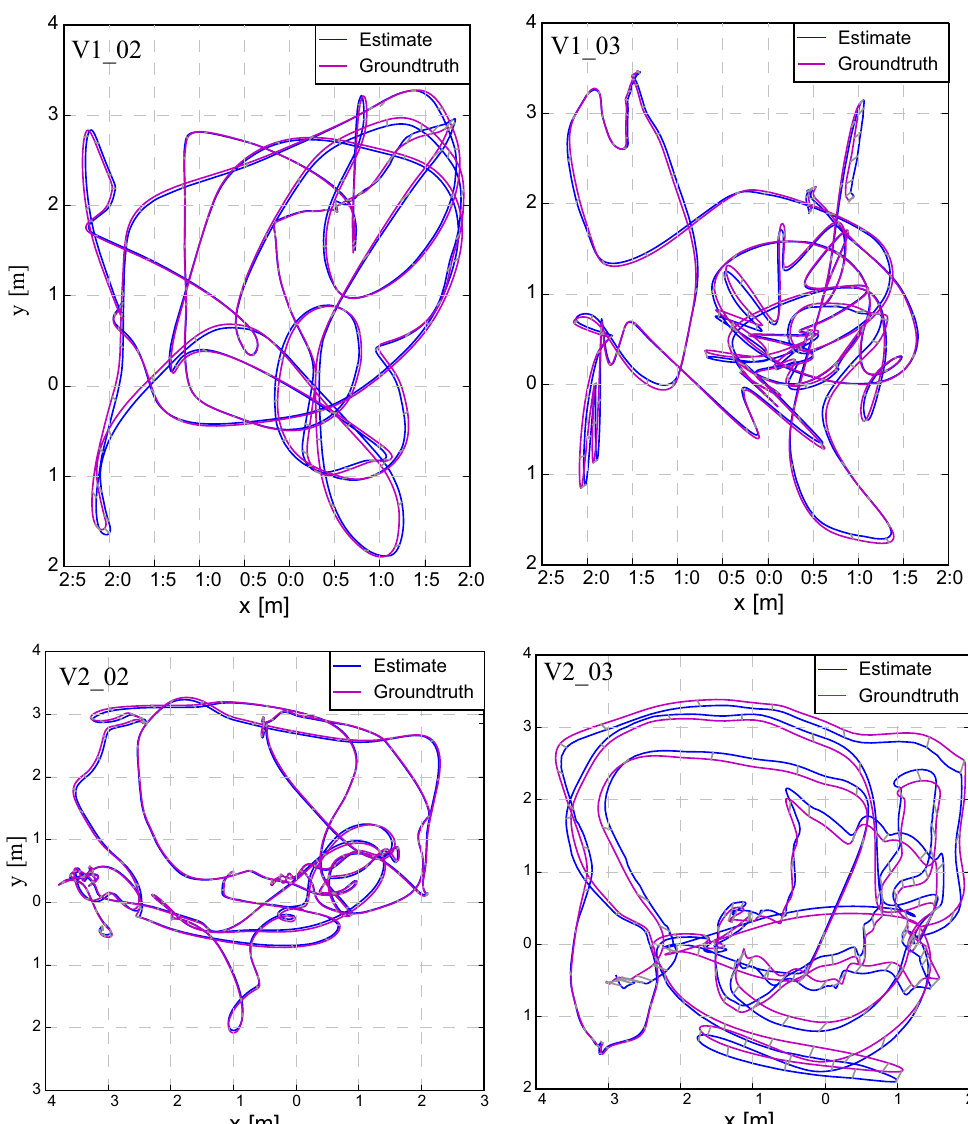
Figure 8. A comparison between the estimated trajectory (blue line) and the ground-truth (magenta line) by the proposed method on sequence V1_02, V1_03, V2_02, and V2_03 are expressed following the gravity direction.